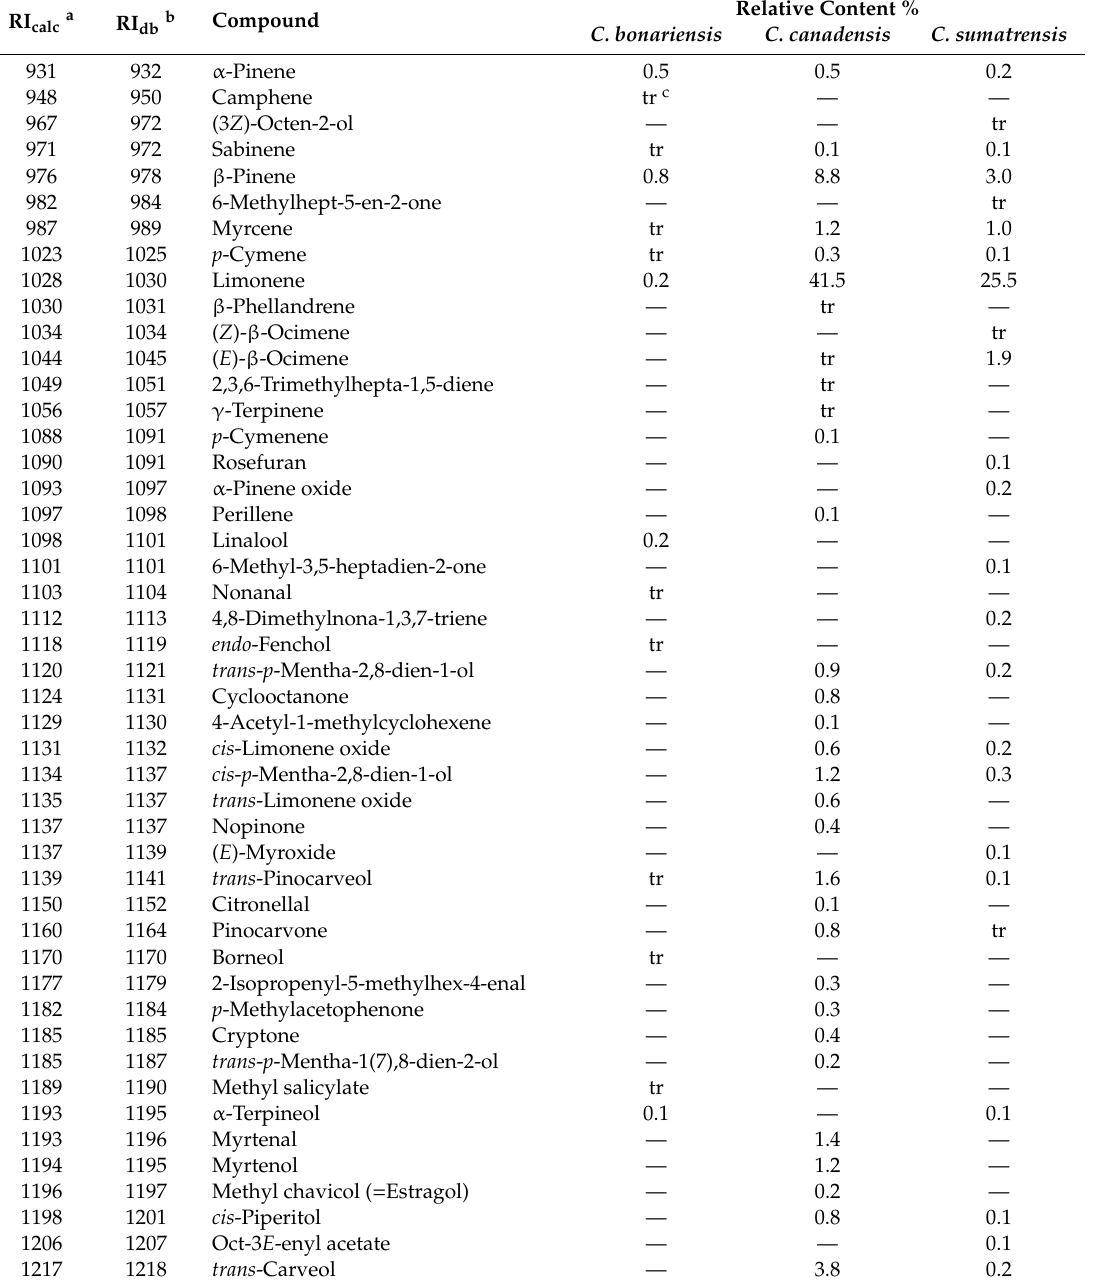
Table 1. Chemical compositions of the aerial parts essential oils of Conyza bonariensis , Conyza canadensis , and Conyza sumatrensis collected in